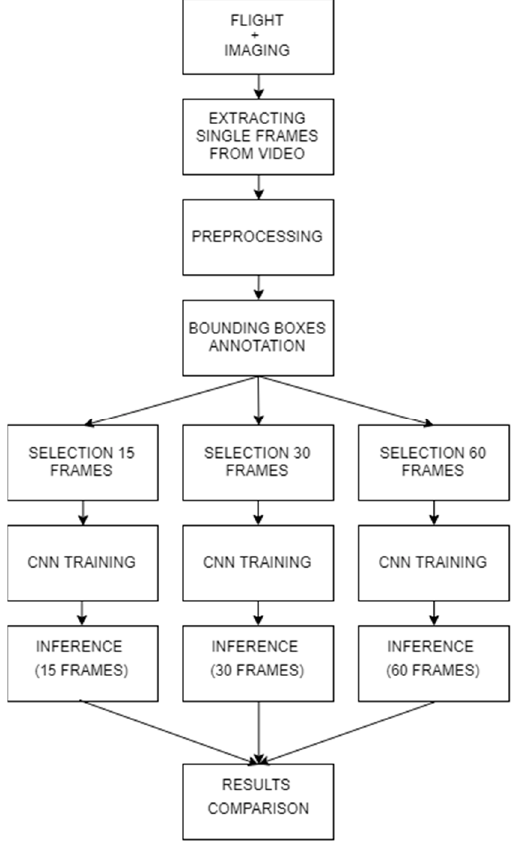
Figure 1. Subsequent stages of the research experiment.